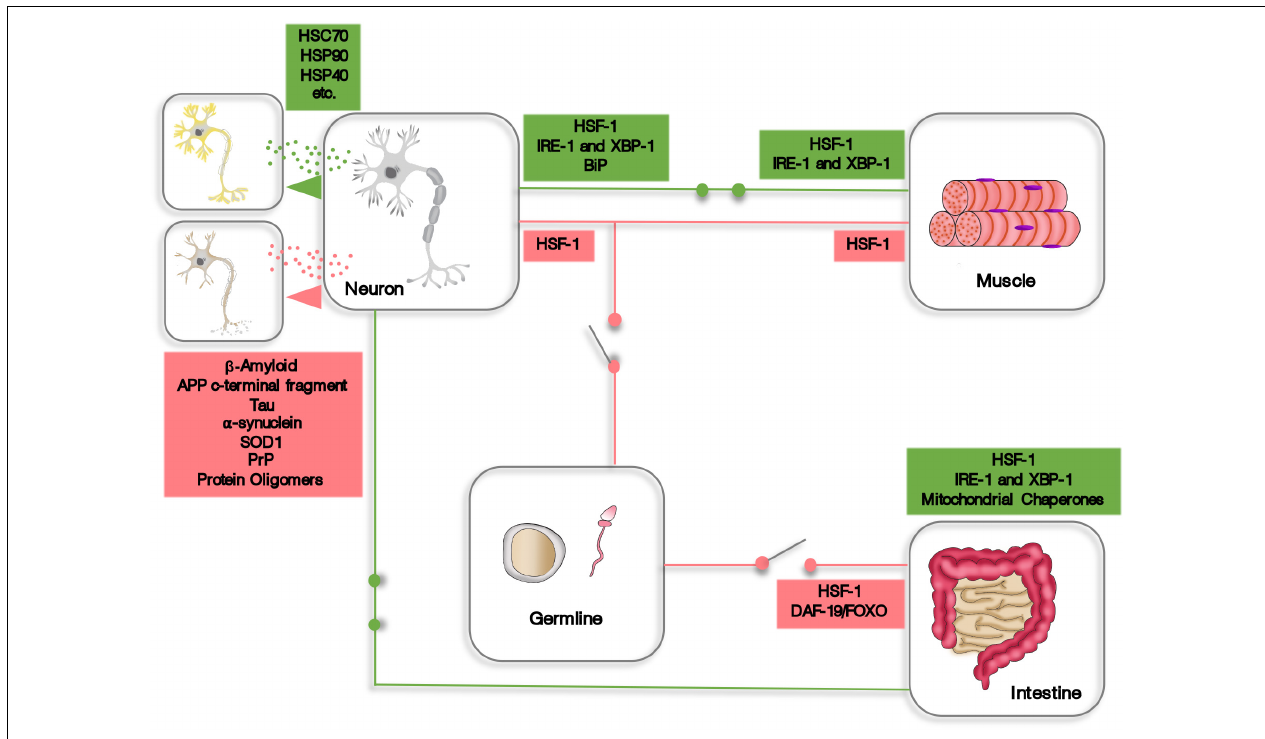
FIGURE 1 | A schematic representation of some aspects of cell non-autonomous proteostasis. Expression of HSF-1, XBP-1, and other components of the proteostasis machinery is induced (green circuits) or repressed (red circuits) in one tissue or organ by endocrine signaling originating from distant cells. In addition, cells and tissues can transfer proteostasis machinery or dispose of proteotoxic material using extracellular